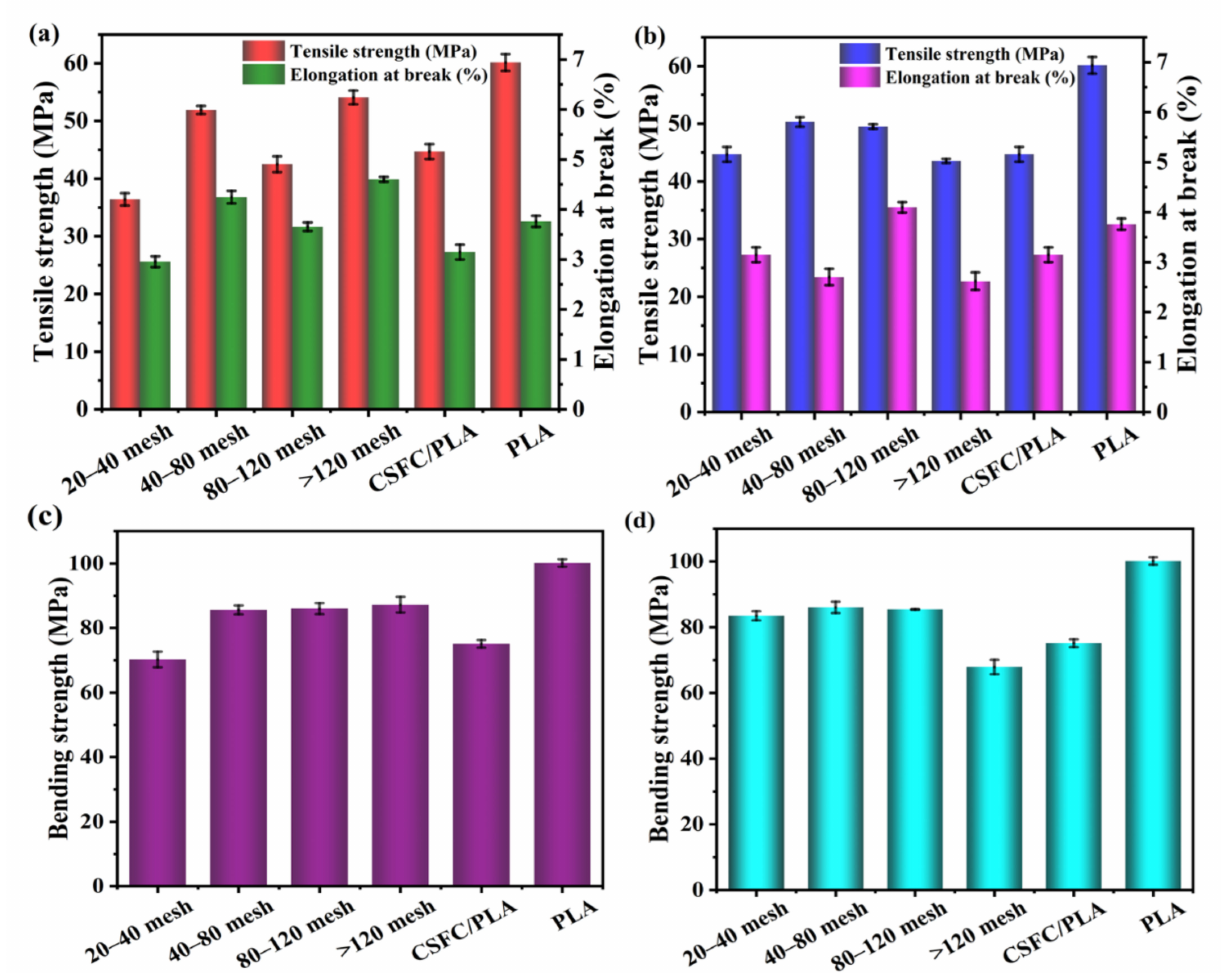
Figure 2. Tensile strength and elongation at break of CSFS/CSFC/PLA composites ( a ) and CSFS/PLA composites ( b ) with different particle sizes; bending strength of CSFS/CSFC/PLA composites ( c ) and CSFS/PLA composites ( d ) with different particle